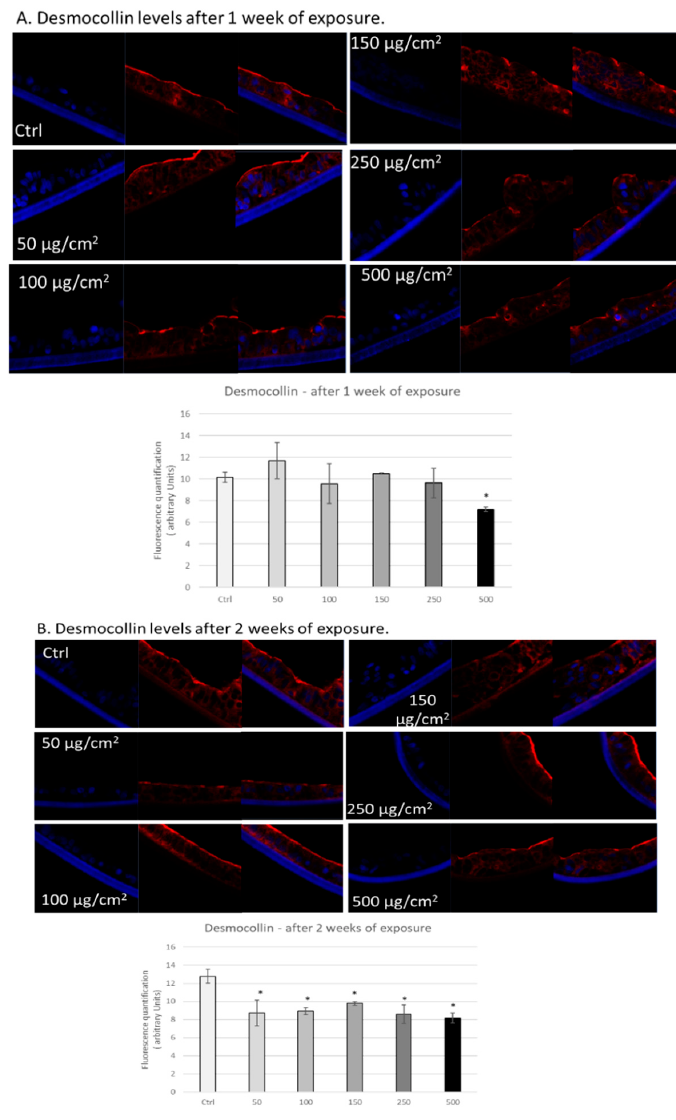
Figure 5. Exposure to particulate matter decreased levels of desmocollin after one week and two weeks of exposure. Representative immunofluorescence images of levels of desmocollin (red color) in 3D intestinal tissues after one week (A) or two weeks (B) of exposure with the following doses of PM: 50, 100, 150, 250, and 500 µg/cm 2 . Red staining represents desmocollin. Blue staining represents DAPI. Quantification of at least three independent images taken of stained tissues from two independent experiments is represented in graphs A and B. Data are expressed as arbitrary units (averages ± SEM of two experiments, *p < 0.05).